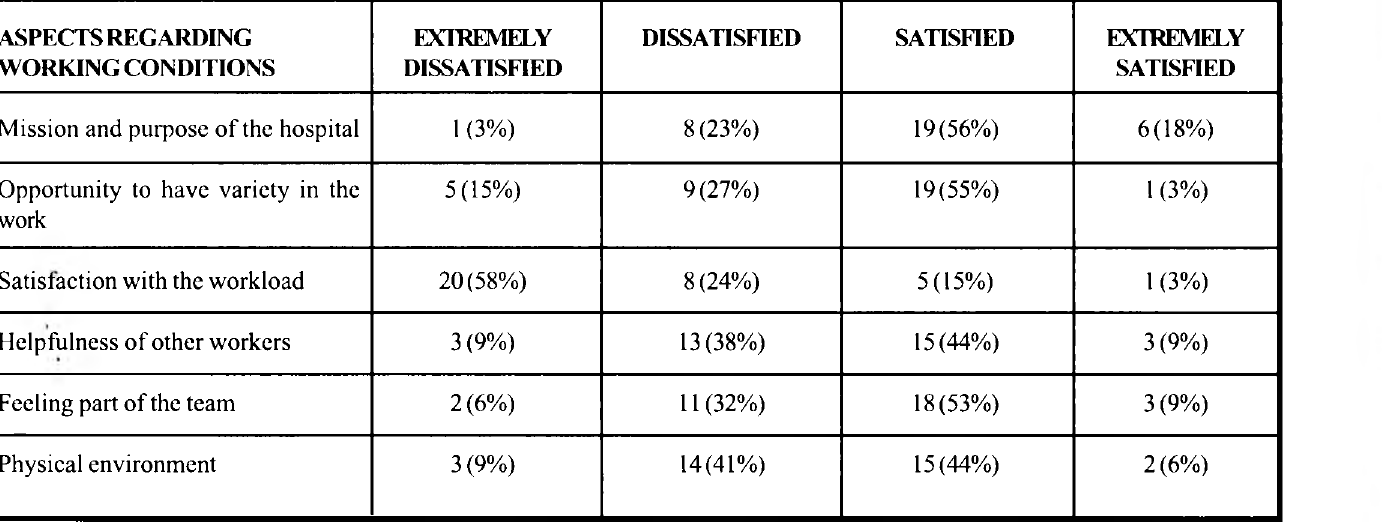
Table 1: Satisfaction / dissatisfaction with working conditions (n=34) ASPECTS